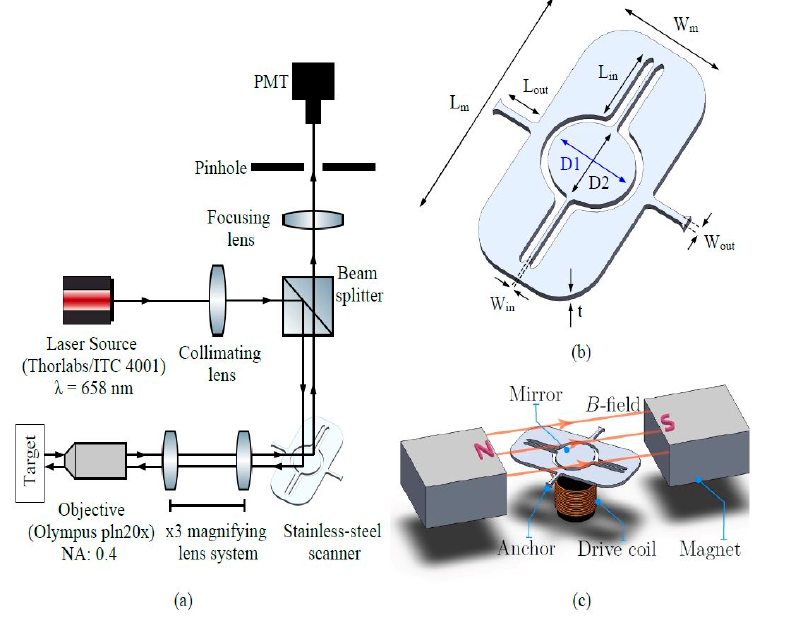
Figure 1. ( a ) Schematic of the custom-built confocal microscope; ( b ) 3D view of the proposed